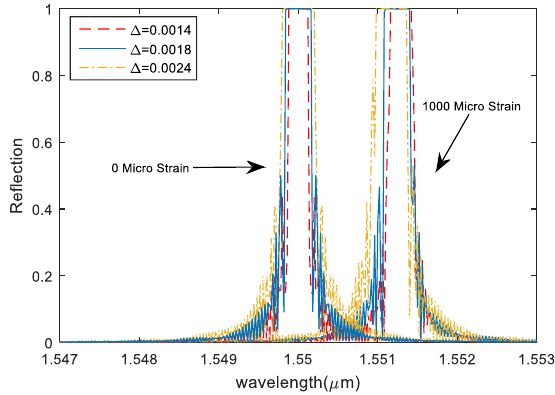
Figure 9: Reflection response in FBG as a function of refractive index difference under 0 and 1000 micro strain.